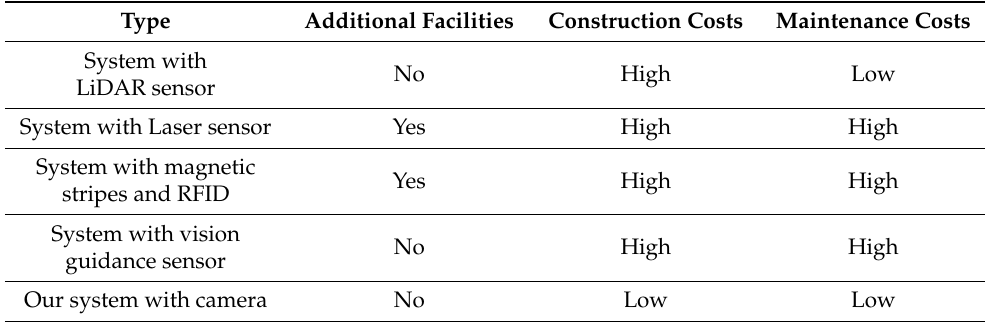
Table 4. Comparison with other